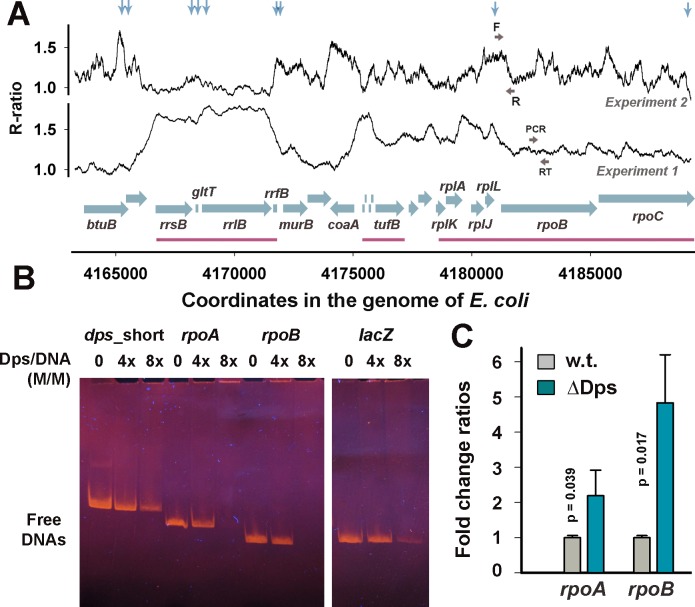
Deletion of the dps gene affects rpoA and rpoB expression.A: Profiles of the Dps binding sites obtained in two experiments (indicated) for the genomic region with three operons of ribosomal genes (running window of nine 35 bp bins). Genes are represented by blue horizontal arrows; magenta lines show ribosomal operons. Vertical arrows mark locations of inverted repeats (if longer than 7 bp). B: Band shift assays performed for indicated genomic loci. The regulatory region of the dps gene was used as a positive control for all band shift assays in this study. Fragment from the lacZ coding sequence was used as a reference gene for qRT-PCR experiments. Positioning of primers for amplification (F and R) is indicated in panel A of this figure, Fig 6A (for the dps regulatory region) and in S3 Fig (for rpoA and lacZ). C: Changes in the expression efficiency of selected genes in response to dps deletion. Primers used for reverse transcription and consecutive PCR are designated as RT and PCR, respectively, here and all other figures. Expression levels were estimated based on 3 and 5 biological samples (3–18 technical repeats in each) for rpoA and rpoD, respectively. Error bars show an average deviation. Statistical significance was assessed using Student’s t-test.